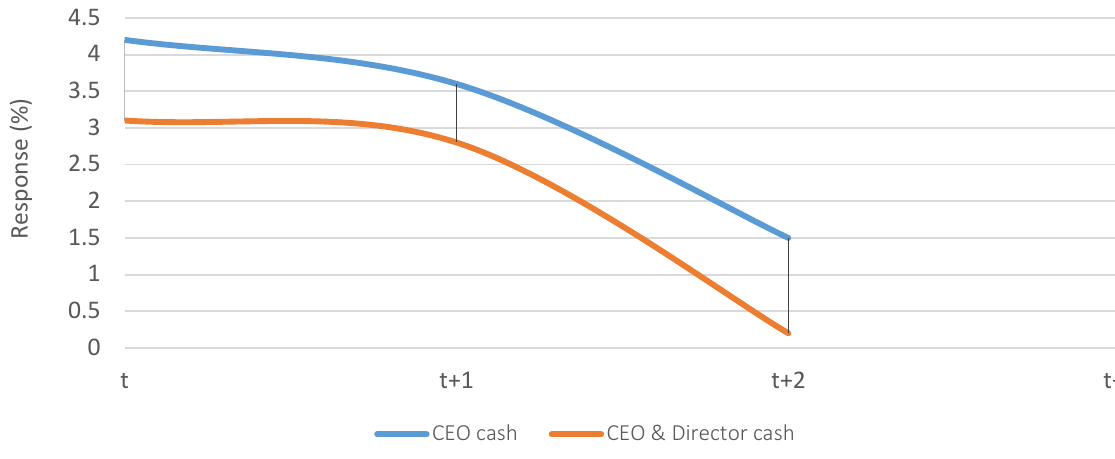
Figure 8. Response of CEO and Director cash pay to ROE